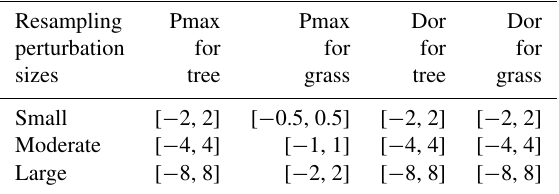
Table 4. Resampling perturbation